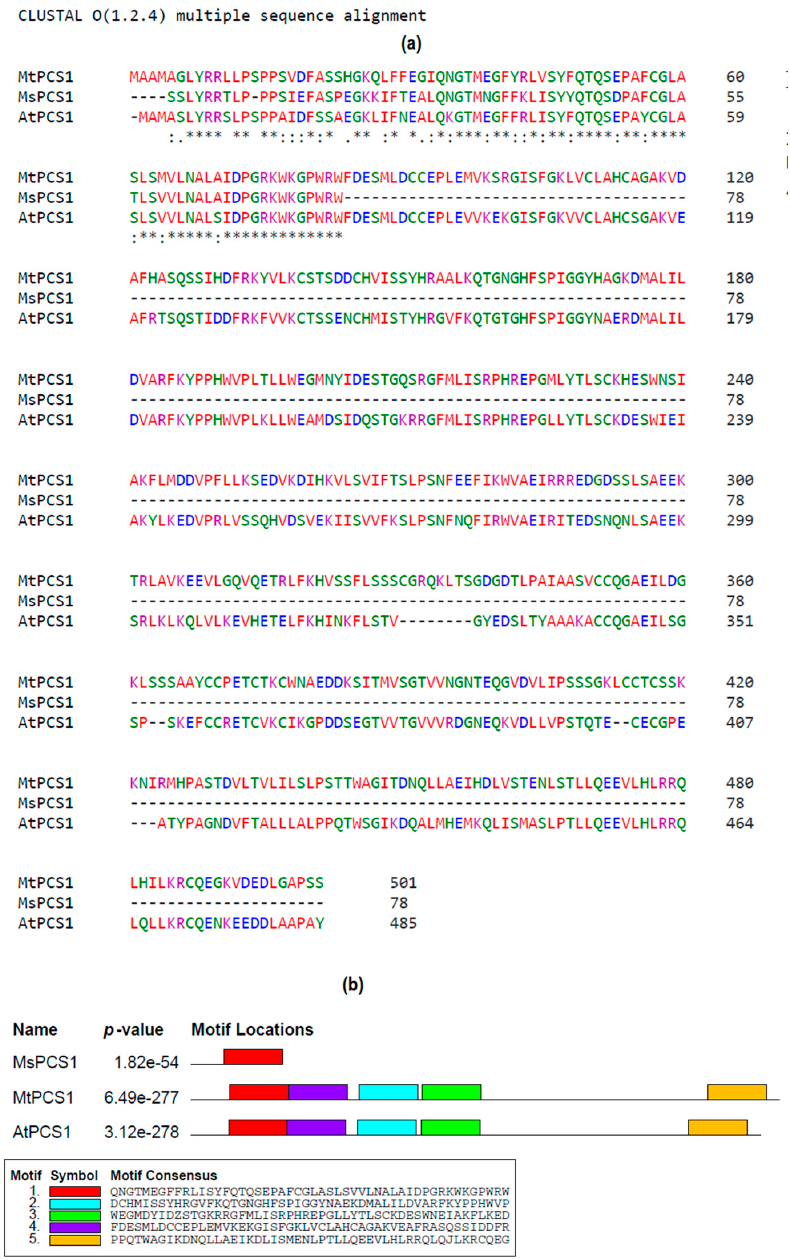
Figure 6. In silico characterization of the MsPCS1 protein in different bioinformatics platforms. Multiple sequence alignment ( a ) and the motif locations related to the phytochelatin synthase domains ( b ).